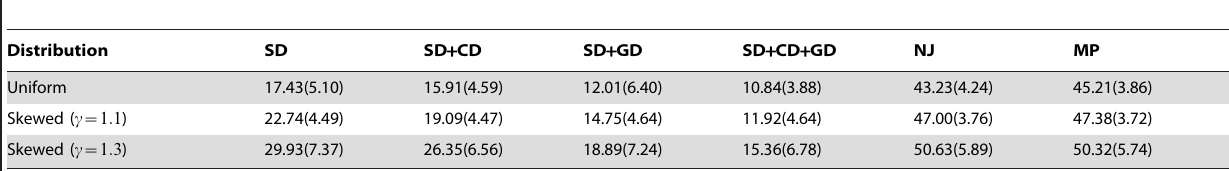
Table 2. Comparison of mean percentage reconstruction error (with standard deviation) of different phylogeny models on simulated data for different sampling distributions of the cells.